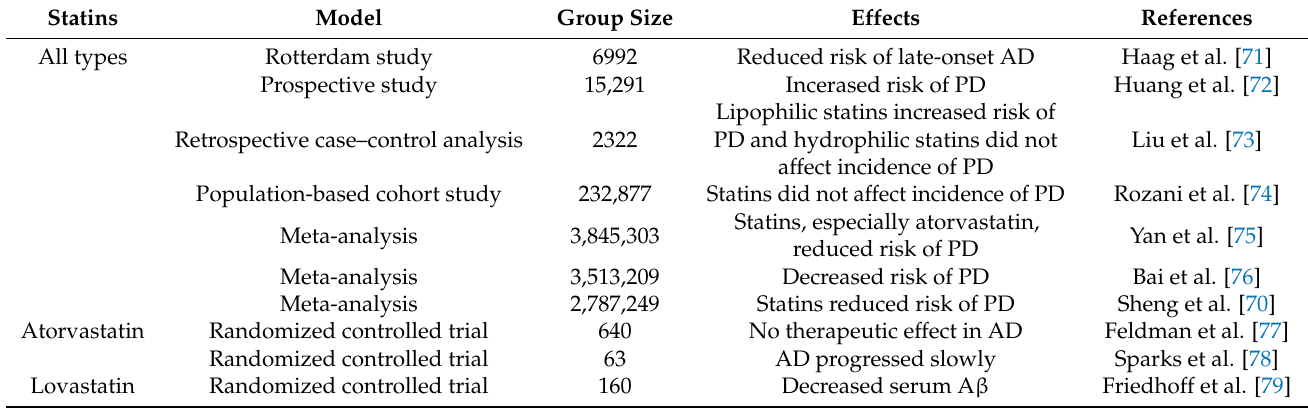
Table 1. Studies on the efficacy of statins for prevention of Alzheimer’s disease (AD) and Parkinson’sdisease (PD). Statins Model Group